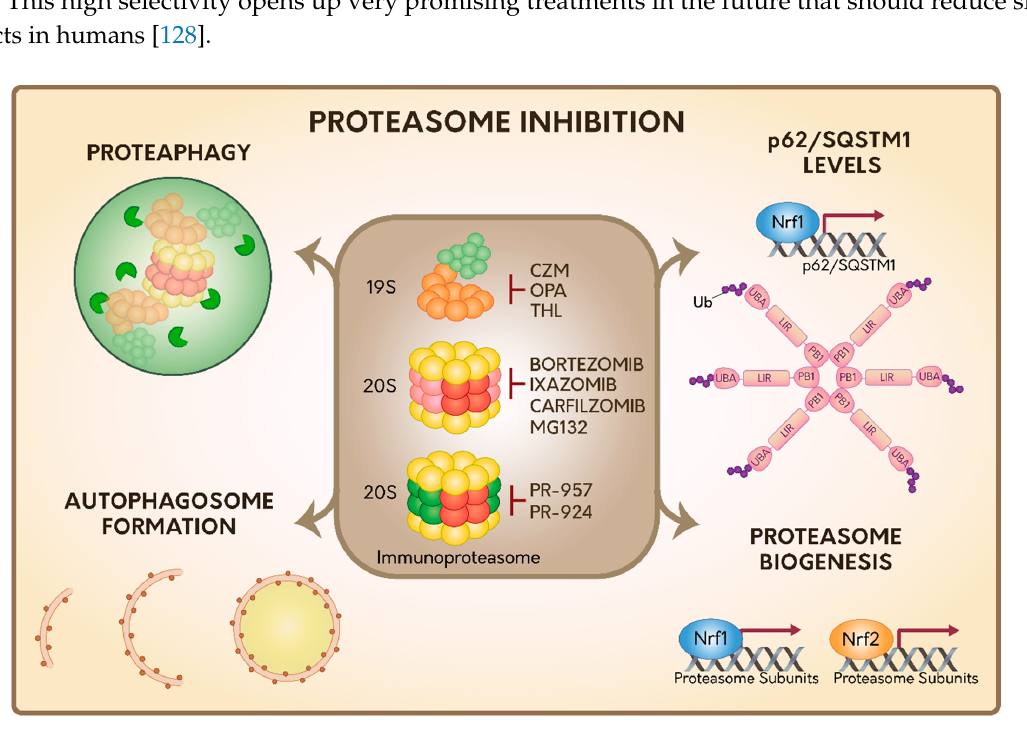
Figure 2. Summary of the cellular responses during proteasome inhibition. Several proteasome inhibitors have been described targeting 19S RP, 20S proteasome and immunoproteasome. In response to proteasome inhibition, several responses are activated specifically related with the 20S proteasome, including the Autophagic-Lysosomal Pathway (ALP), proteaphagy, the transcriptional upregulation of the autophagy Ub receptor p62/SQSTM1, and proteasome genes, by Nrf1 and Nrf1/Nrf2 transcription factors, respectively. The activation of the autophagy Ub receptor p62/SQSTM1 is dependent on specific post-translational modifications based on ubiquitylation. However, it is still unknown which responses could be activated under the inhibition of 19S RP or immunoproteasome.